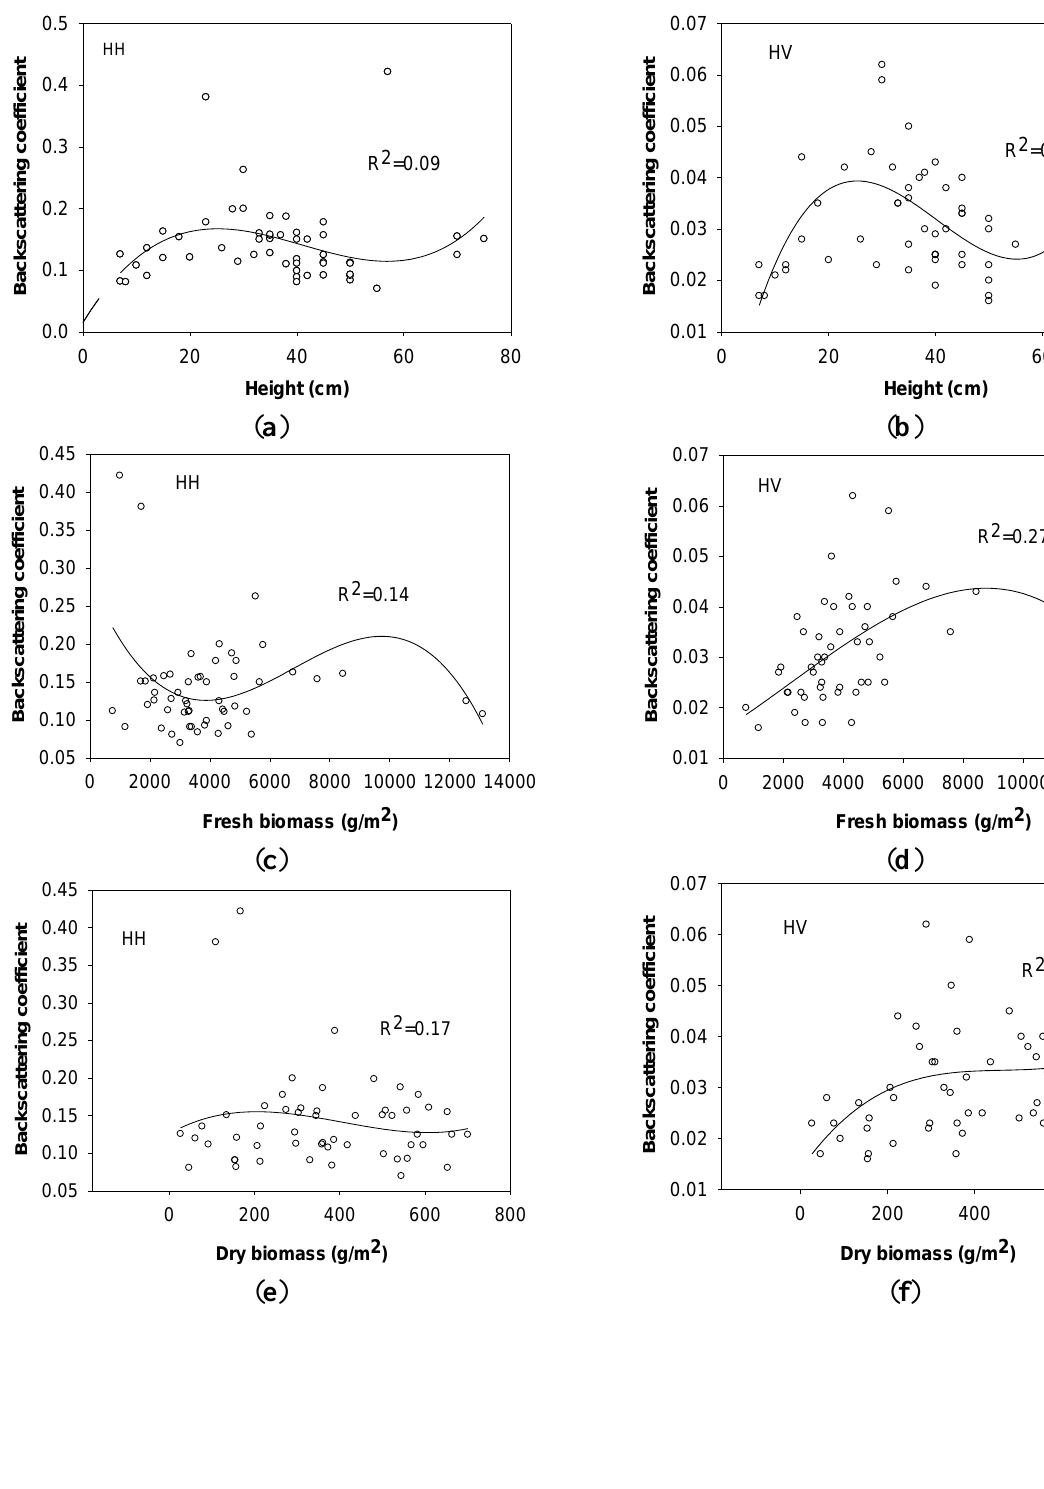
Figure 7. Scatter plots of ASAR backscatters in HH polarization against ( left panel ) plant height, fresh biomass, dry biomass, and vegetation water content; and HV polarization against ( right panel ) plant height, fresh biomass, dry biomass, and vegetation water content of Carex spp. ( a , b ) plant height, ( c , d ) fresh biomass, ( e , f ) dry biomass, and ( g , h ) vegetation water